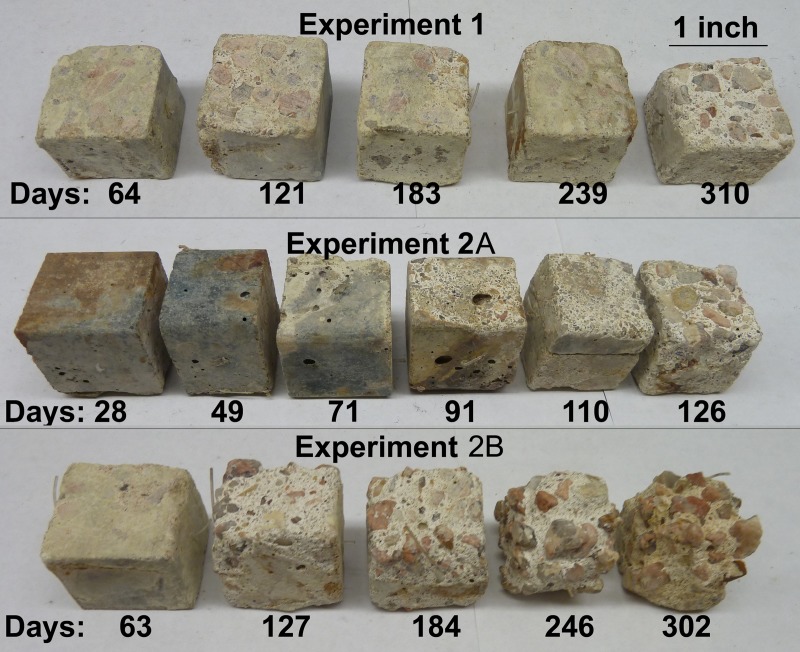
Cubic concrete specimens after exposure to corrosive environments in a wastewater manhole.Corroded material was removed and specimens were dried prior to photographing.